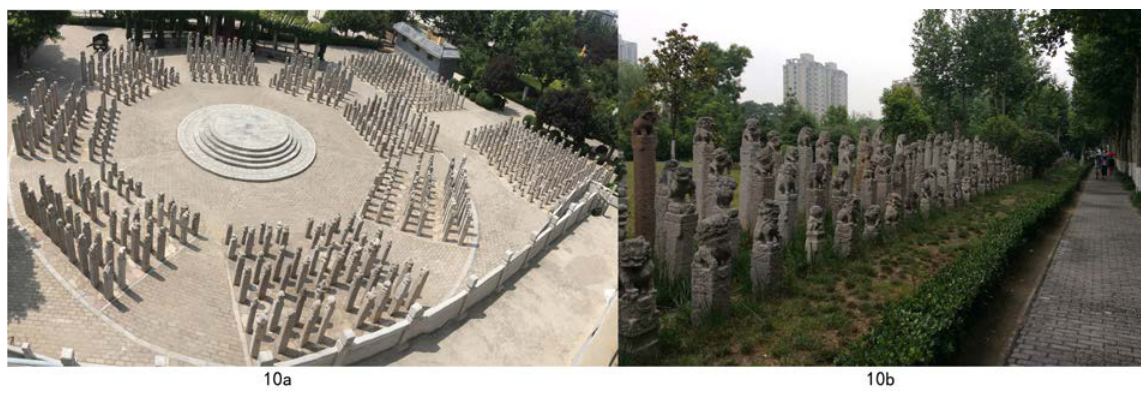
Figure 10. Recent arrangements (photos by Ke Bai): a) Exhibition in matrix of Eight-Diagram position, Chengcheng county museum; b) Landscape in campus of Xi’an Fine Art